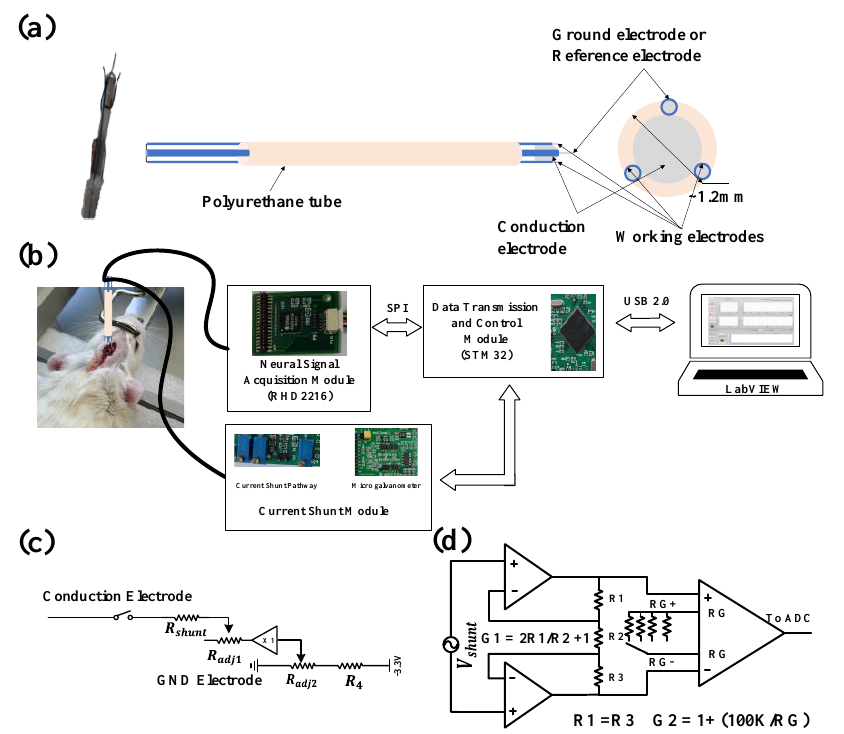
Figure 1. Developed system and protocol for recording the iEEG signal and shunt-current densityin a Sprague Dawley rat. ( a ) Schematics of the electrode design; ( b ) the architecture block diagram of a closed-loop adjustable shunt-current intensity circuit and system for current conduction treatment of epilepsy; ( c ) the circuit diagram for the current shunt module; ( d ) the circuit diagram for the micro galvanometer, where Vshunt is the voltage drop across the current sensing resistors (R shunt1 and R shunt2 ).